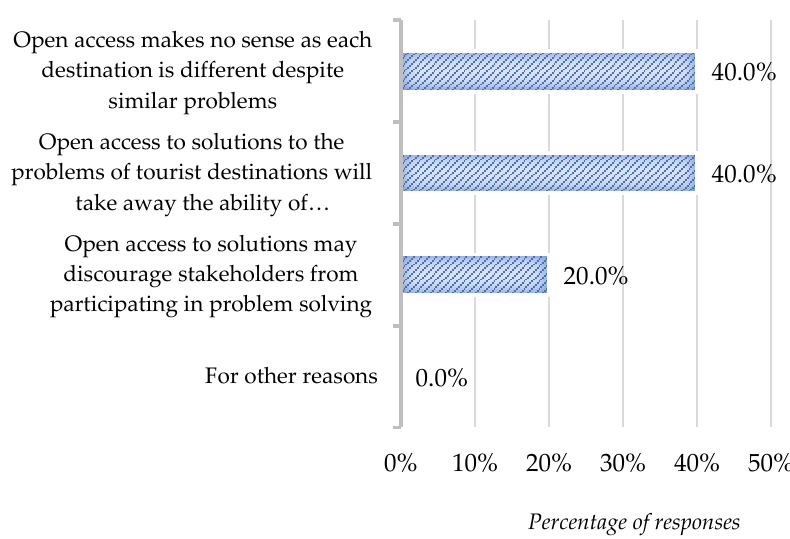
Figure 6. Distribution of answers to the question: ‘ Why should innovative solutions not be open innova- tion? ’ Source: Own study.